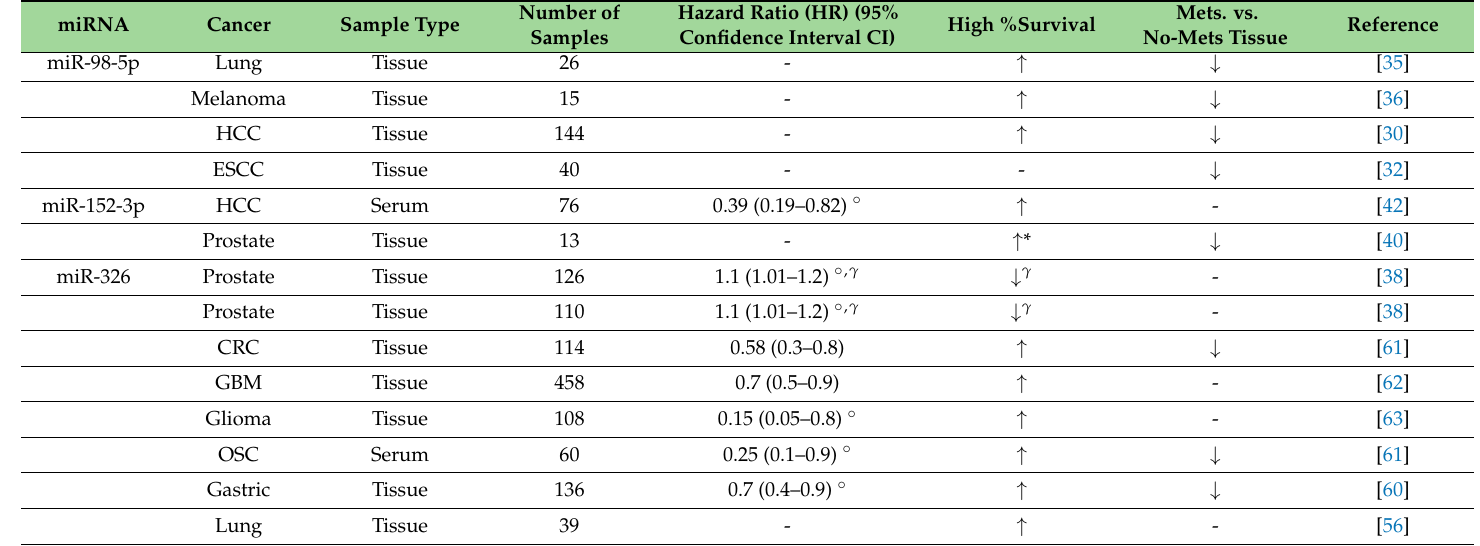
Table 2. Dysregulation of miR-98-5p, miR-152-3p, miR-326 and miR-4289 associated with cancer prognosis.